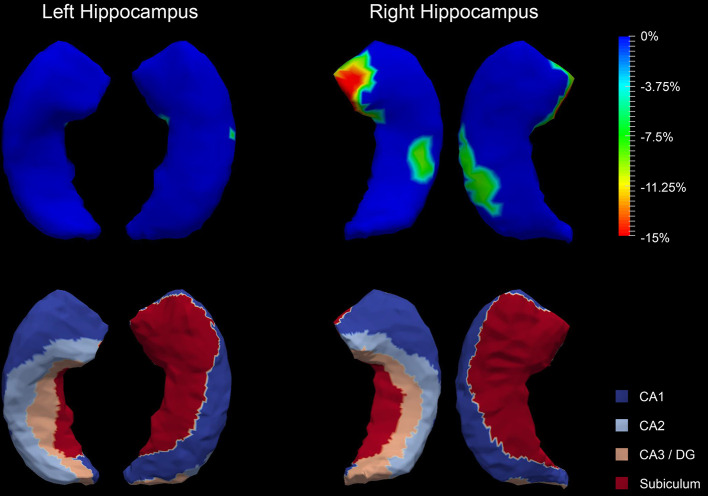
Shape analysis results for the bilateral hippocampi. Statistically significant group comparison results for the hippocampal shape in each hemisphere as well as the corresponding subregion definitions. The color bar represents the percentage of atrophy at a specific vertex in first-episode schizophrenia (FES) relative to healthy control (HC). The bottom panel illustrates the four subregions of the bilateral hippocampi. Two views (left: lateral, right: medial) are presented for each case.